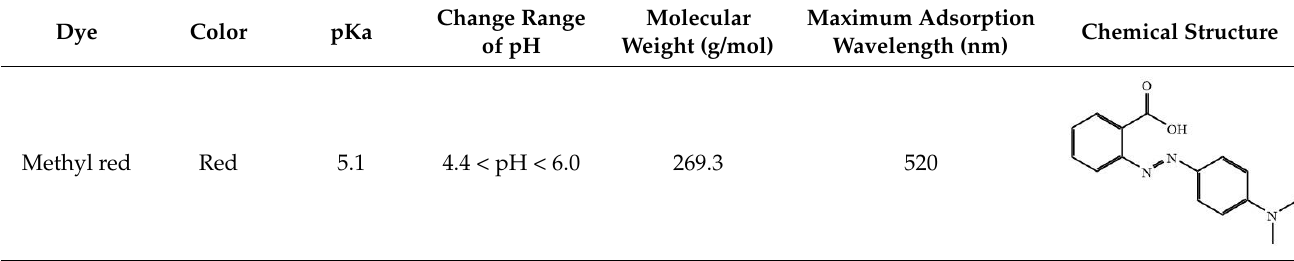
Table 1. Properties of MR used in this study.